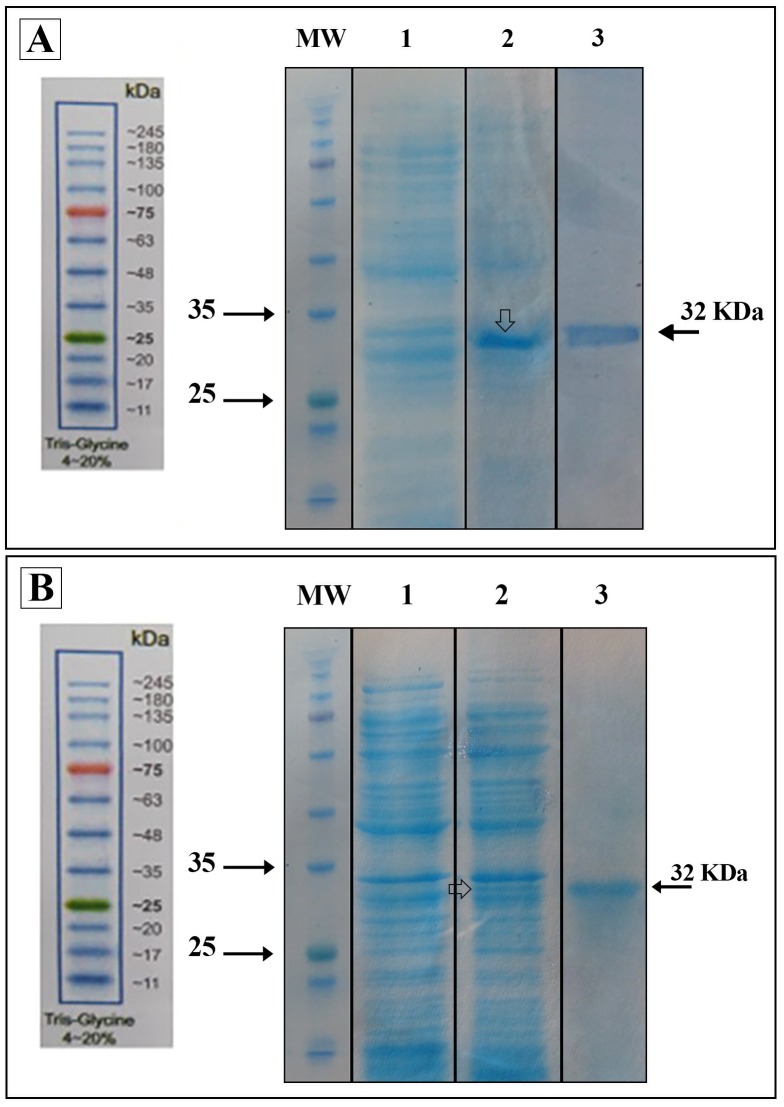
Expression and purification of the recombinant polyepitope peptides in E. coli Rosetta expression system.(A) Lane 1: Before IPTG induction (BI), Lane 2: After IPTG induction (AI), Lane 3: The purified Nef-Vif-Gp160-P24 polyepitope peptide by affinity chromatography under denaturing conditions. The purified Nef-Vif-Gp160-P24 migrated as a clear band of ~32 kDa in SDS-PAGE; (B) Lane 1: Before IPTG induction (BI), Lane 2: After IPTG induction (AI), Lane 3: The purified Nef-Vpu-Gp160-P24 polyepitope peptide by affinity chromatography under denaturing conditions. The purified Nef-Vpu-Gp160-P24 migrated as a dominant band of ∼32 kDa in SDS-PAGE.